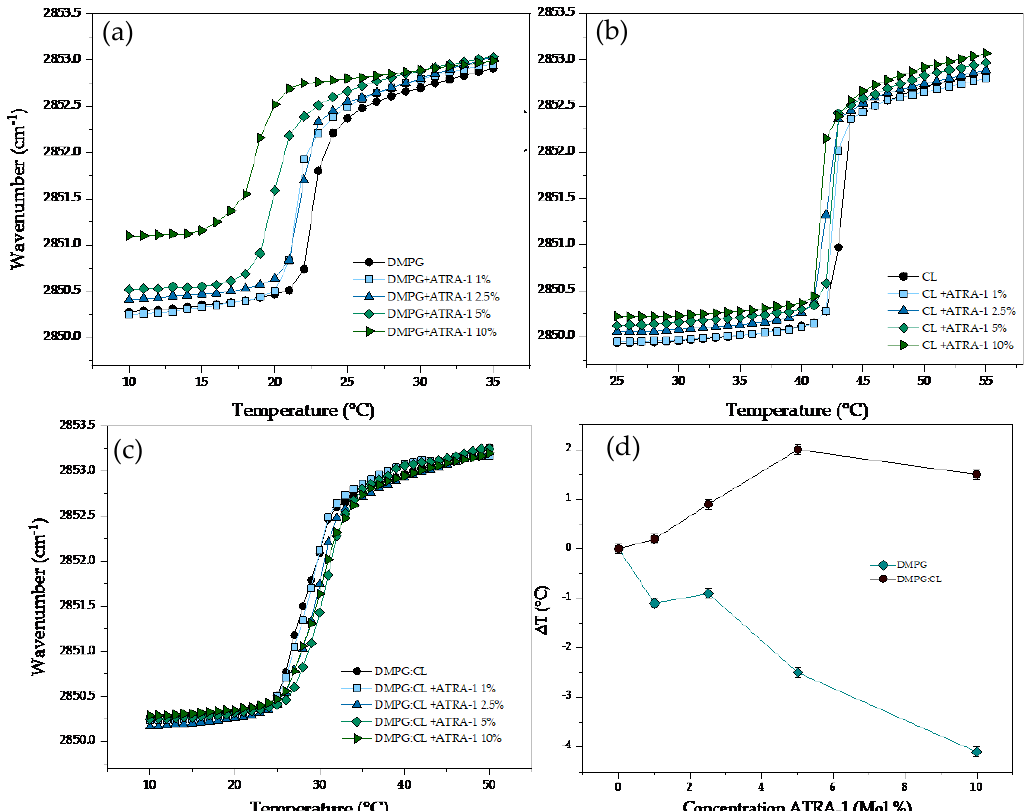
Figure 6. Peak positions of the symmetric stretching vibration bands of the methylene groups as a function of temperature. Different concentrations of ATRA − 1 in supported lipid bilayers of ( a ) DMPG, ( b ) CL and ( c ) DMPG:CL. ( d ) Change of T m ( (cid:52) T) in the DMPG and DMPG:CL. Table 3. Phase transition temperatures (T m ) of the three lipids systems in the presence of different concentrations of ATRA-1, as determined by FT-IR. Standard deviations are <0.1 °C. ATRA-1 (mol%) ATRA-1